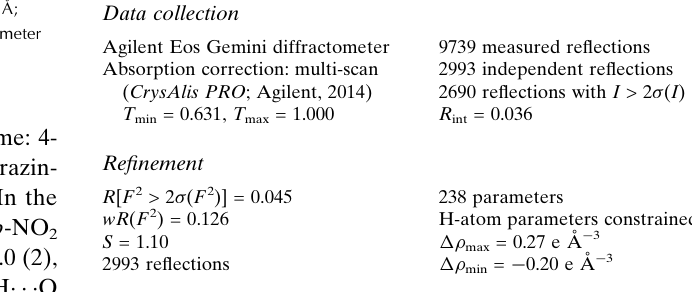
Data collection Agilent Eos Gemini diffractometer Absorption correction: multi-scan